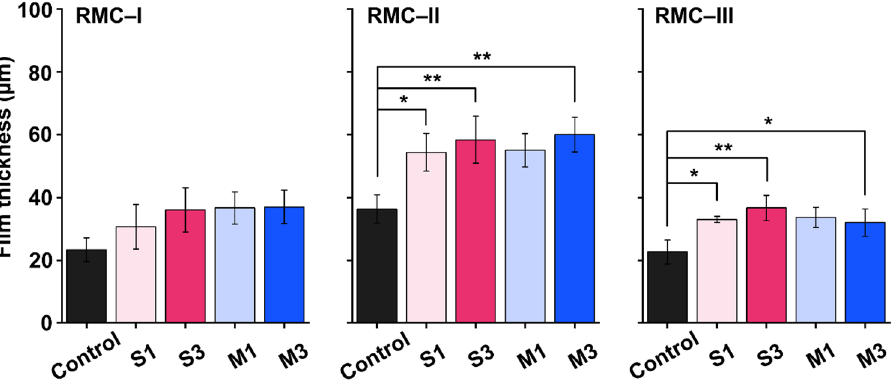
Figure 6. The film thickness of the control groups and experimental groups. A varying number of asterisks indicate significant differences by post-hoc Tukey’s test (* P < 0.05, ** P < 0.01).